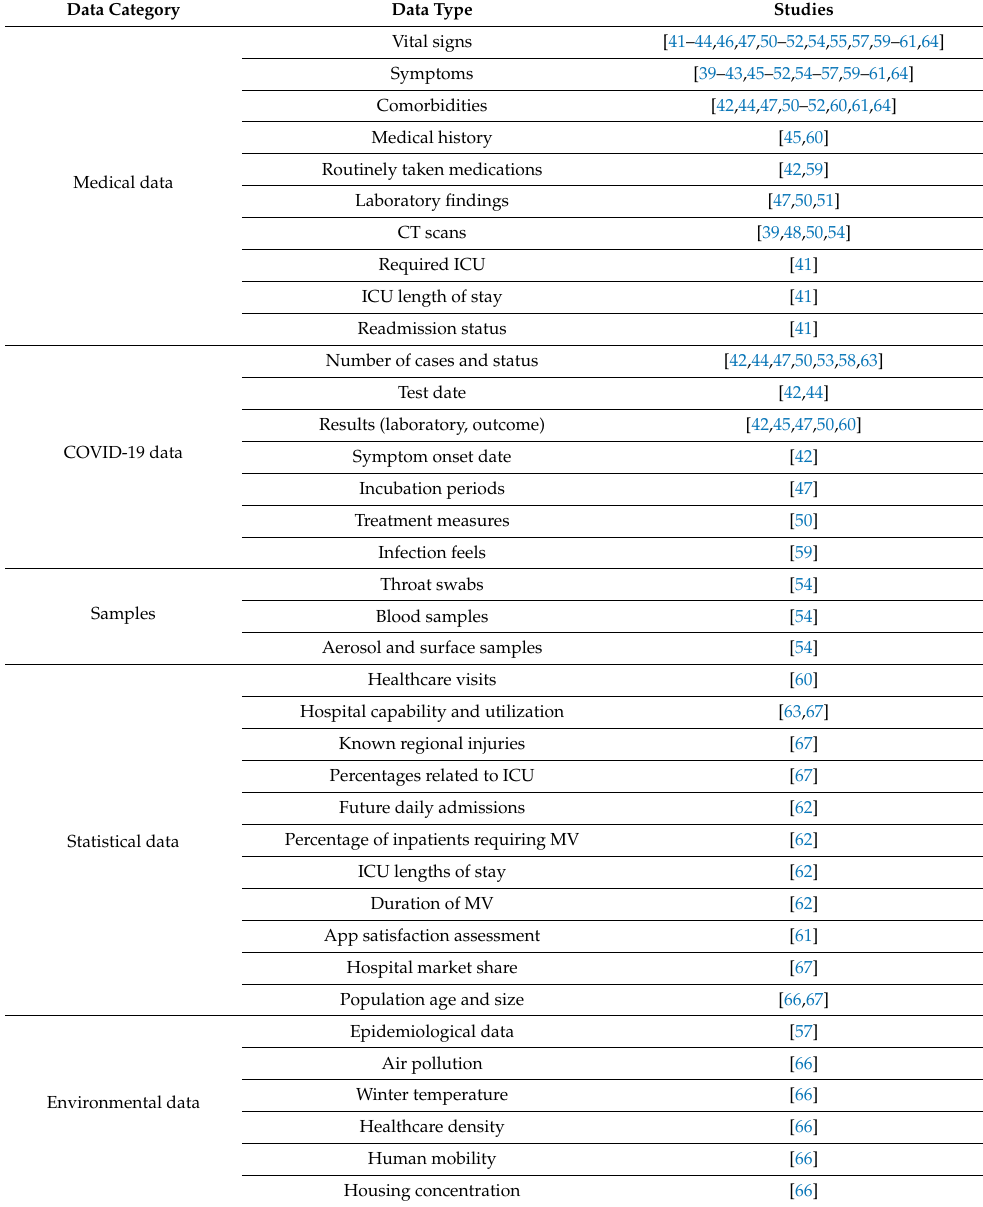
Table 6. Medical, COVID-19, samples, statistical, and environmental data found in the reviewed